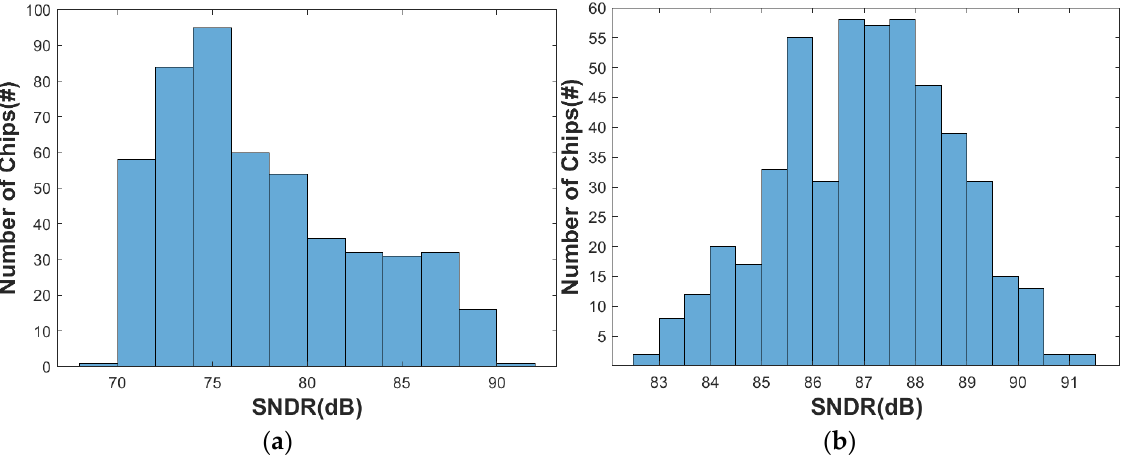
Figure 10. SNDR distribution by amplifier gain variation ( a ) before and ( b ) after digital filter cali- bration.